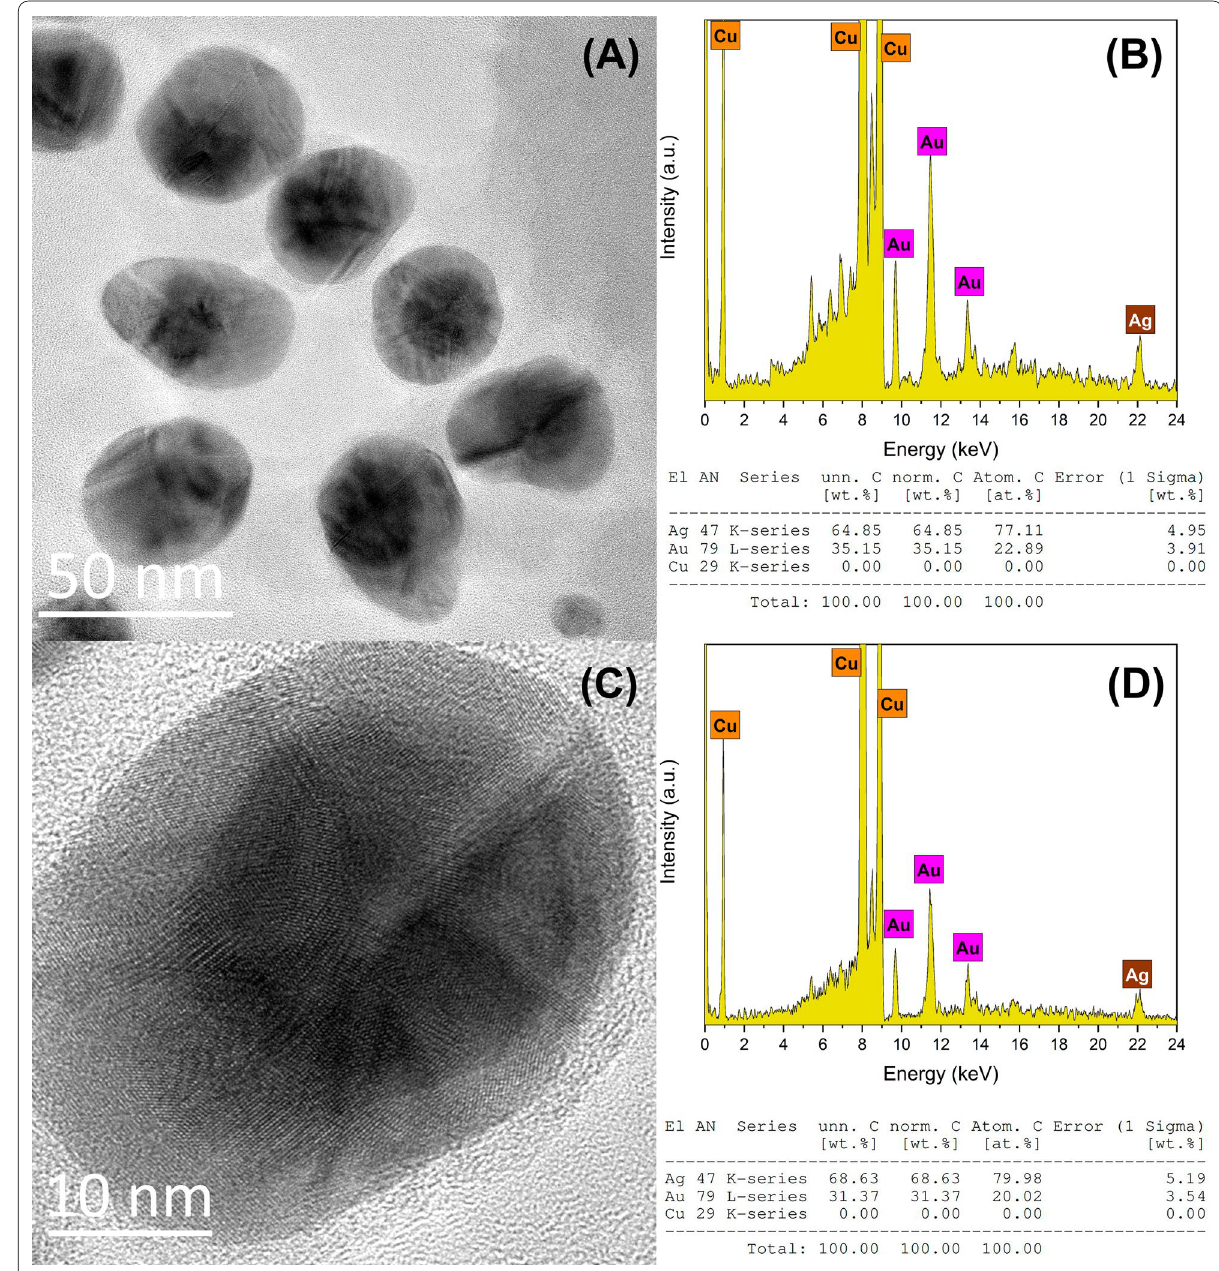
Fig. 6 TEM and EDS of an Au@AgNPs group ( a , b ) with Au 23 and Ag 77% at. and single Au@AgNPs ( c , d ) with Au 20 and Ag 80%